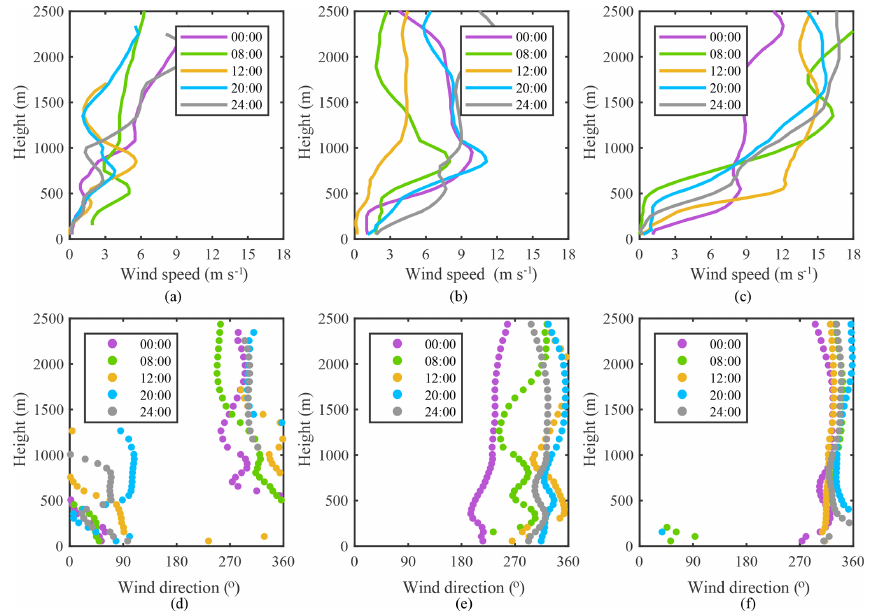
Figure 6. Vertical profiles of wind speed (ms − 1 ) and wind direction ( ◦ ) observed by WPR. (a, d) 17 December 2016; (b, e) 21 December 2016; (c, f) 22 December